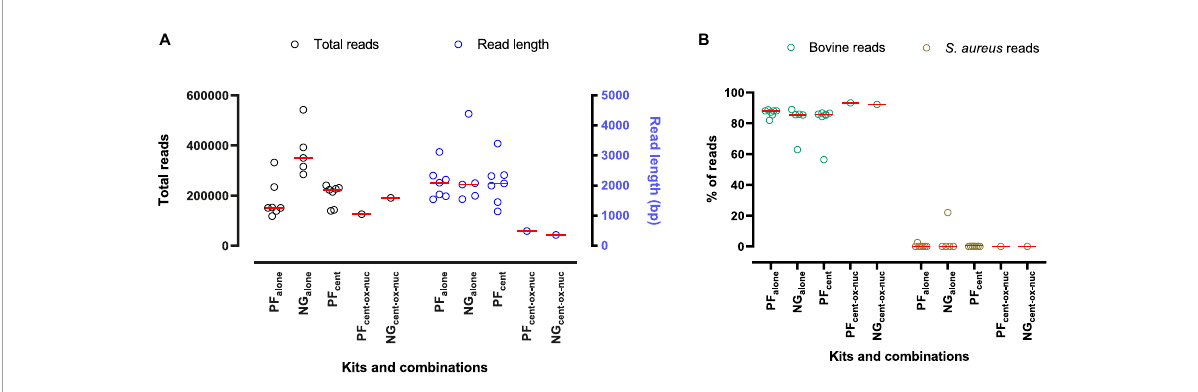
FIGURE1 An overview of MinION sequencing results following DNA extraction from mastitis milk using PF/NG kits and different combinations. (A) Total reads (black circles) and read length (blue circles) following using different commercial kits/combinations. (B) Percentage of reads aligned with the bovine genome (green circles) and Staphylococcus aureus genome (olive circles). Each circle represents a sample, and the mean value is depicted with a red